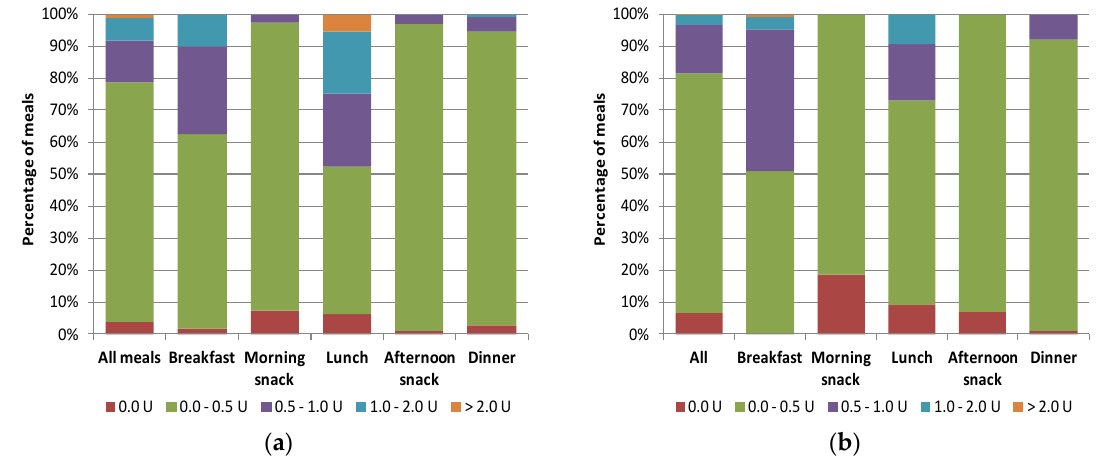
Figure 2. Mean relative absolute differences of insulin doses calculated according to Equation (2) based on estimates of carbohydrate exchange units (CU) and protein–fat exchange units (PFU) provided by the dietitian and the VoiceDiab system for ( a ) dual-wave boluses; ( b ) simple boluses. The insulin to carbohydrate ratio (ICR) was assumed to be 1.5 U/CU for breakfast and 1.0 U/CU for all other meals.